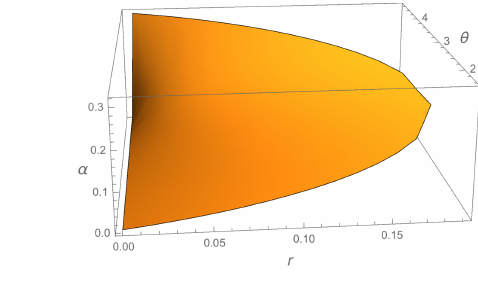
and θ ∈ ( θ ) max 1 , θ 2